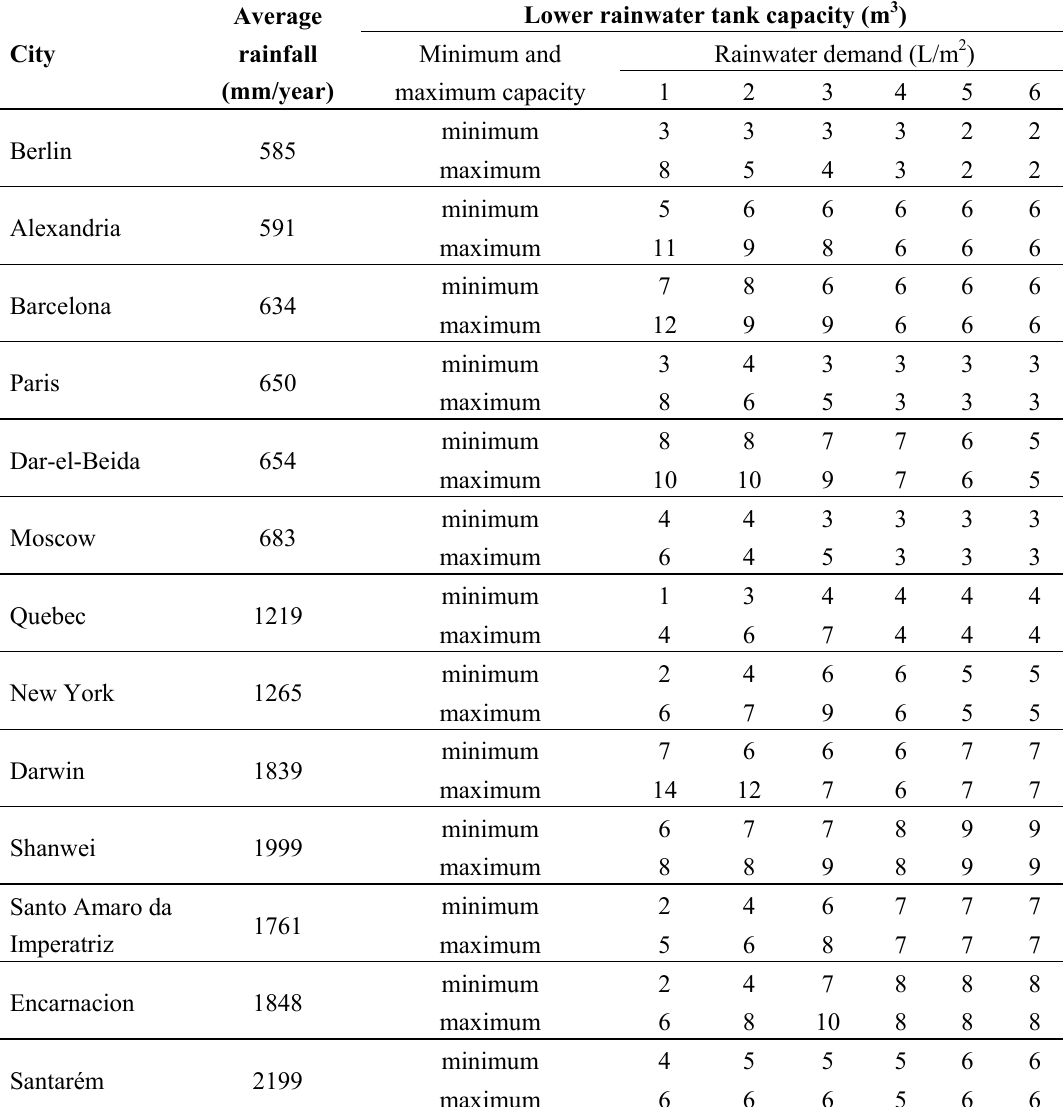
Table 3. Comparison between rainwater demand per catchment area and lower rainwater tank capacity for all